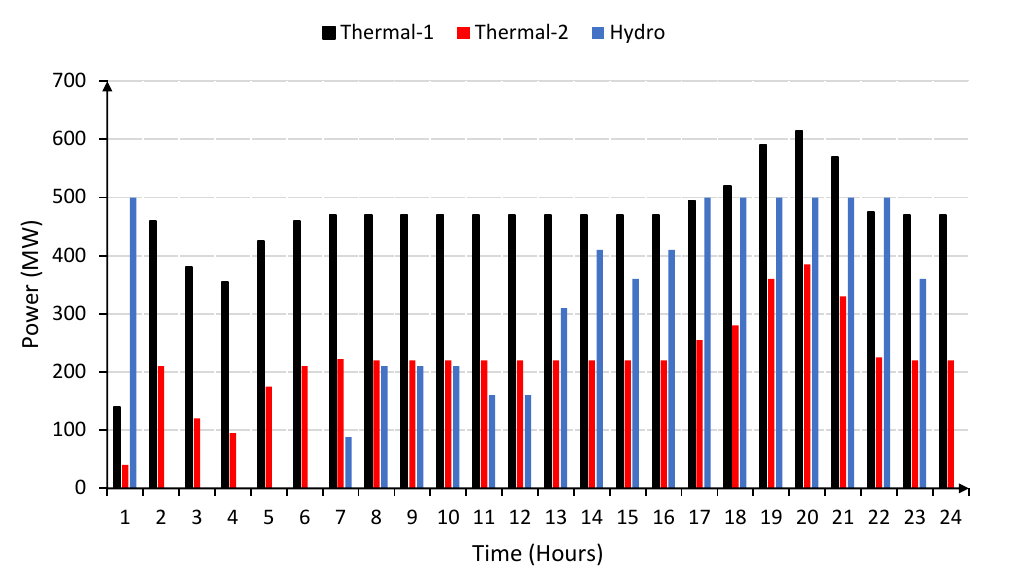
Figure 7. Line power flow during each load interval.